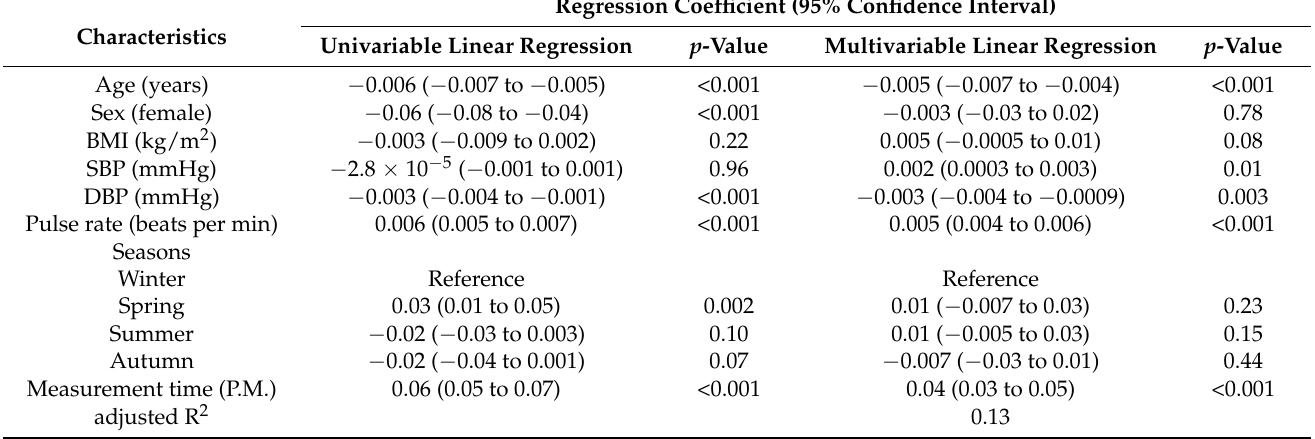
Table 3. Regression coefficients of background parameters for body temperature estimated using ordinary least squares regression